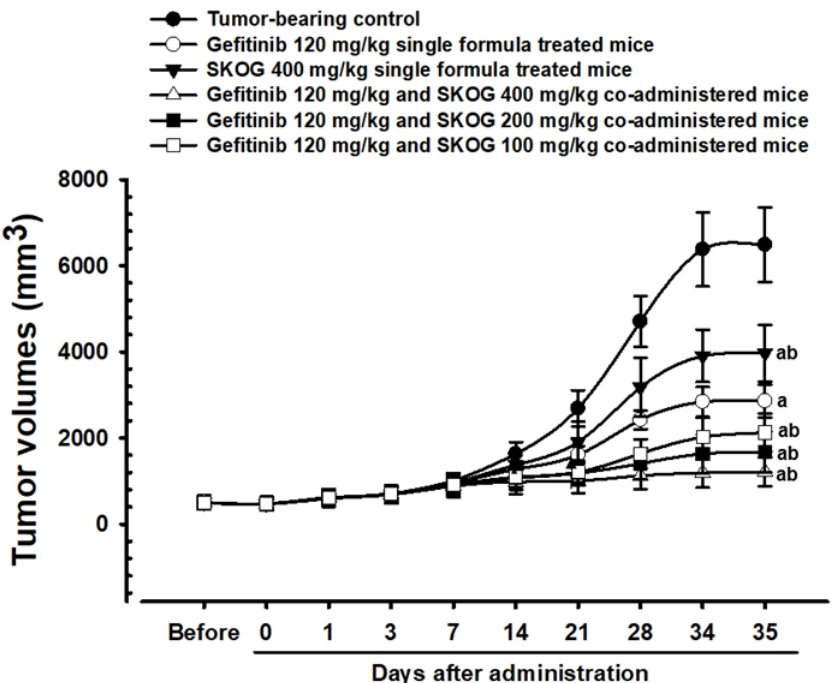
Figure 4. Tumor volume changes in NCI-H520 tumor cell xenograft mice. TB = tumor-bearing; AR = Adenophorae Radix; KOG = Kyeongokgo ; SKOG = sasam-Kyeongokgo . Before means 1 day before the initiation of administration at day 13 day after tumor implantation. a p < 0.01 and b p < 0.05 versus TB control, assessed by the Mann–Whitney U test; c p < 0.01 and d p < 0.05 versus gefitinib-single-for- mula-treated rodents, assessed by the Mann – Whitney U test.